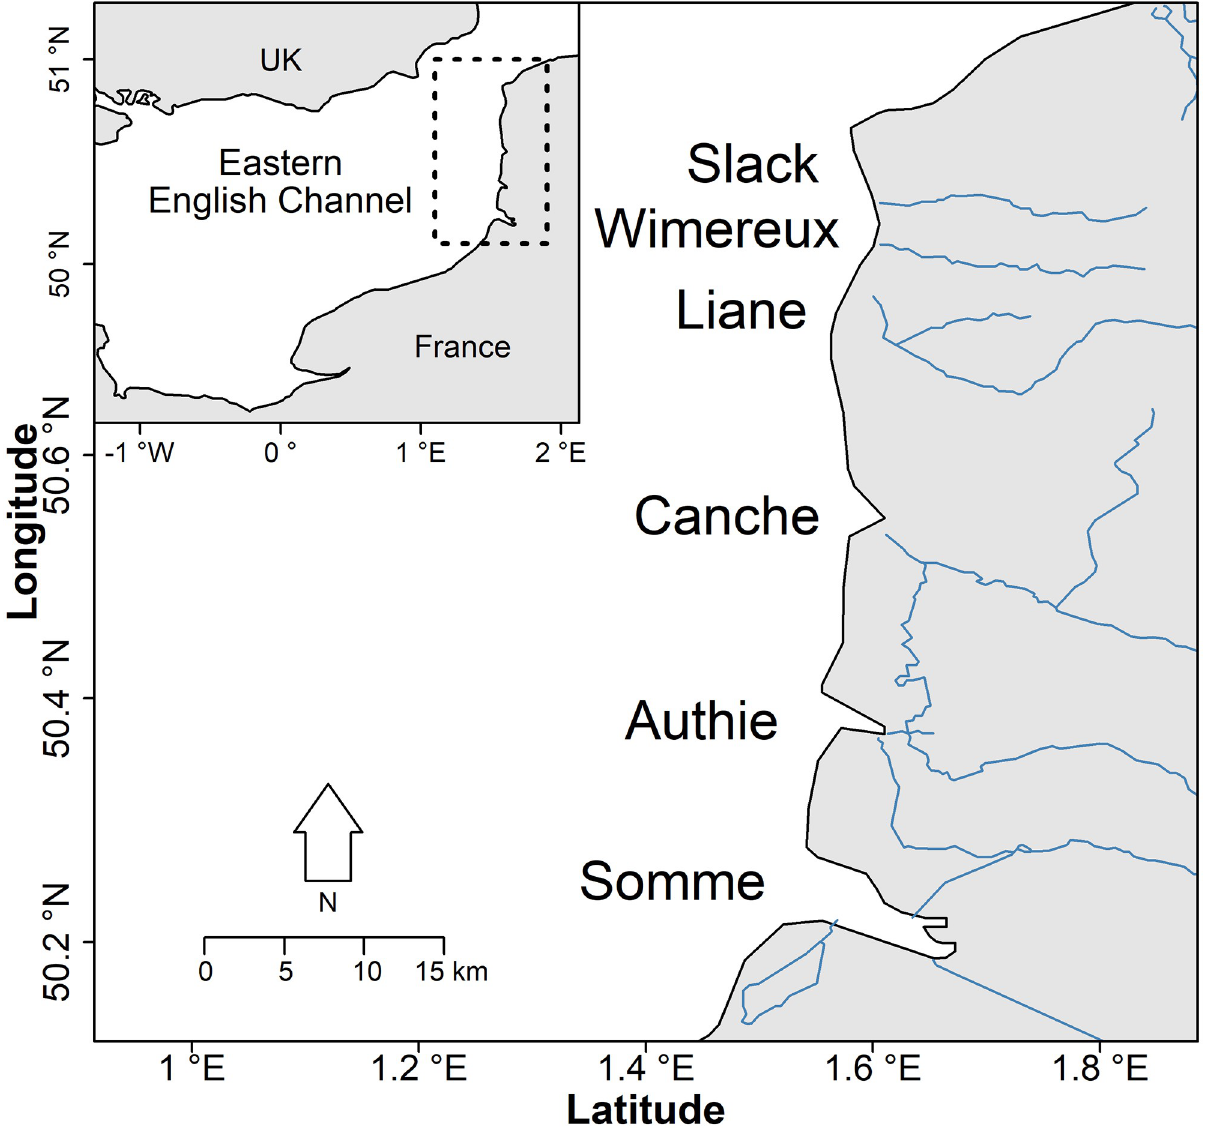
Fig 1. Location of the six estuaries along the French coast in the eastern English